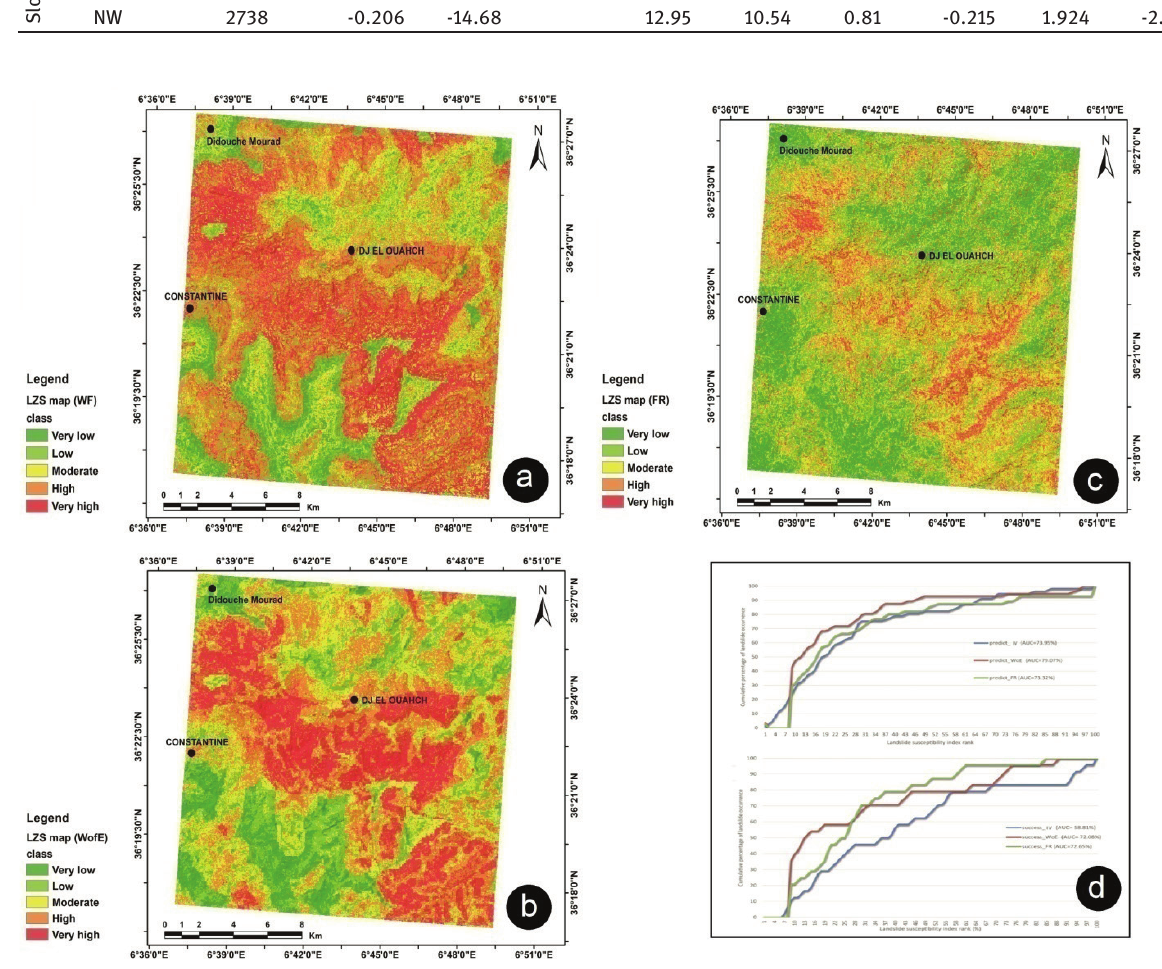
Figure 5: LSMs for a: IV, b: WoE, and c: FR. d: ROC curves of the three used